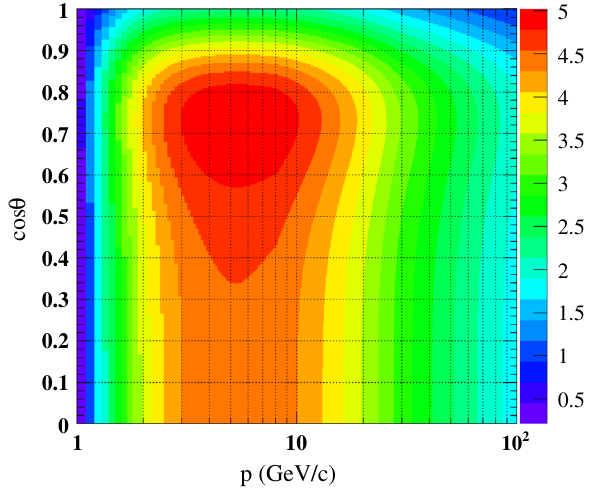
Fig. 4 Separation power S K π between kaons and pions in the p -cos θ plane using dE / dx measurements of the CEPC TPC for the ideal sim- ulation